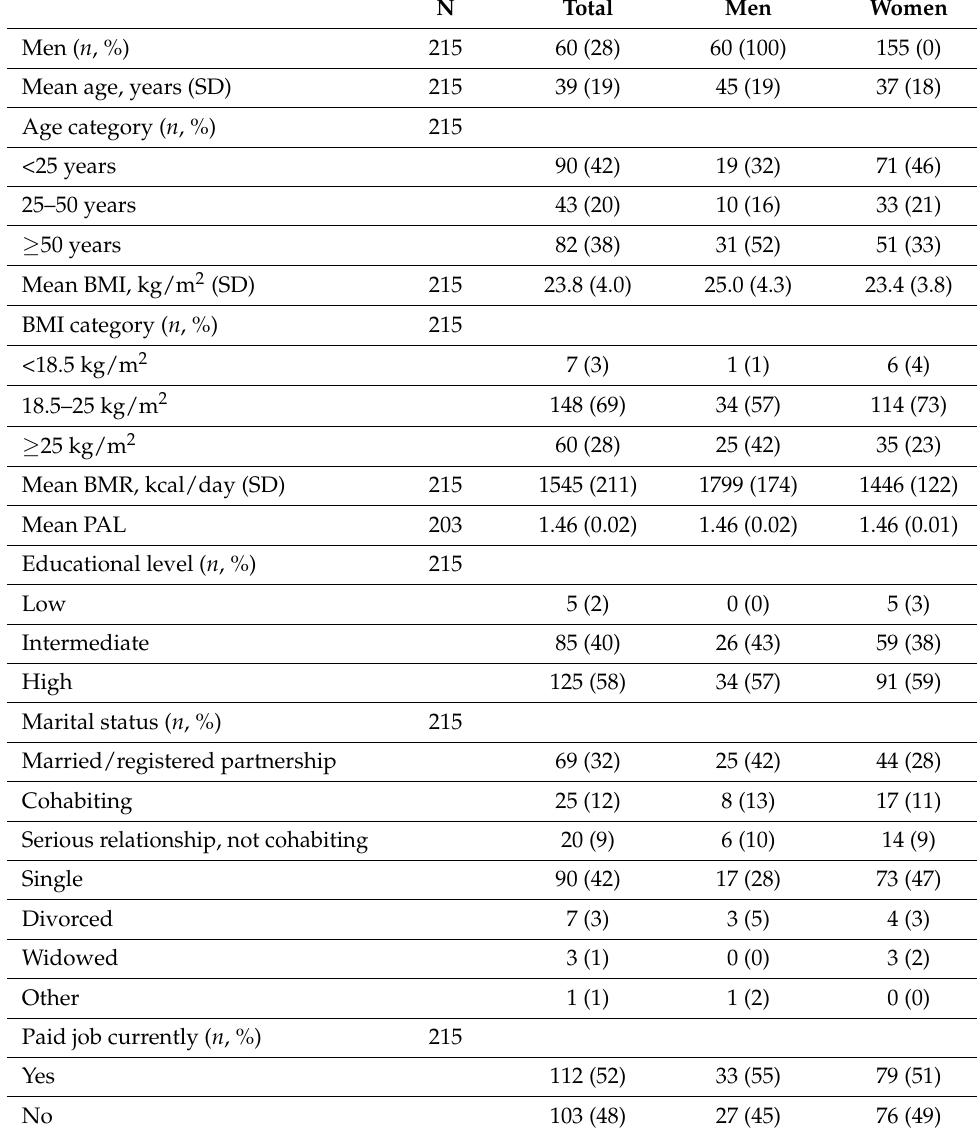
Table 1. Baseline characteristics of the DIASS participants, including collected dietary intake